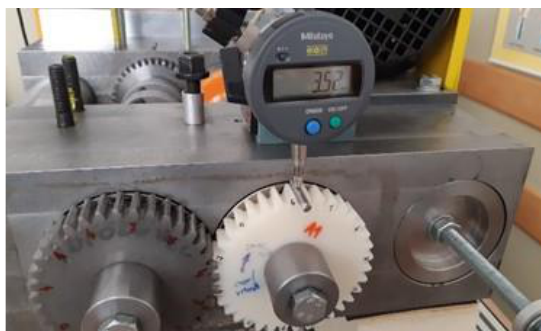
Figure 7. The principle of the testing rig.